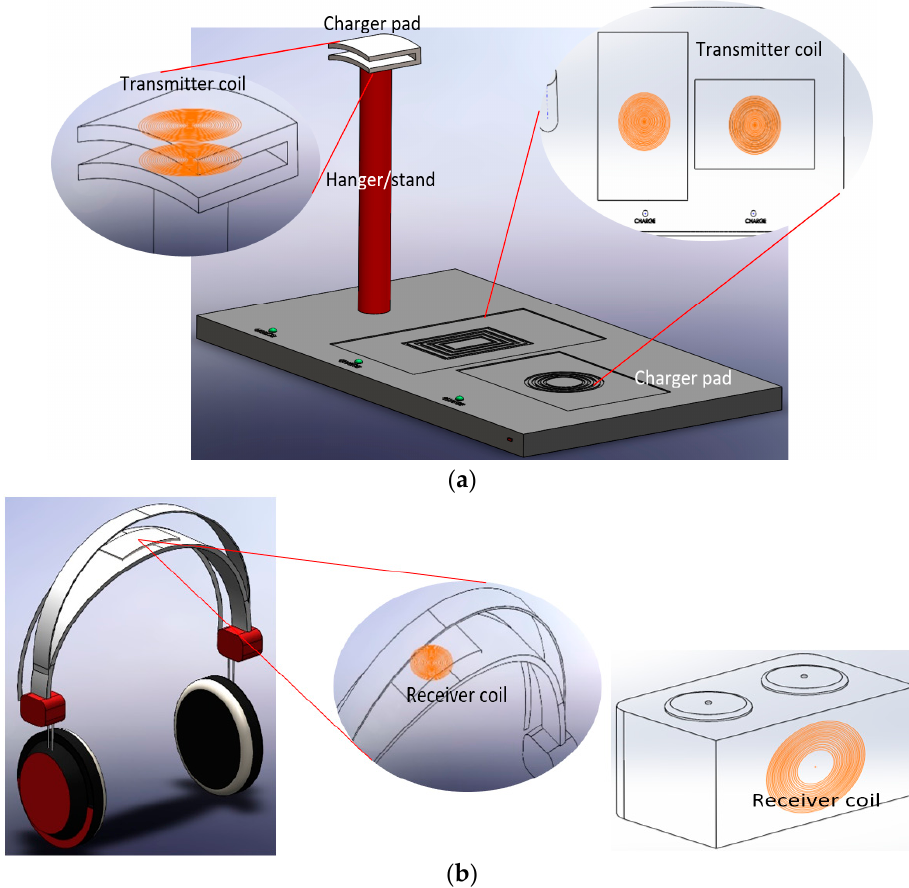
Figure 3. Coil layouts: ( a ) transmitter coil; ( b ) receiver coil.